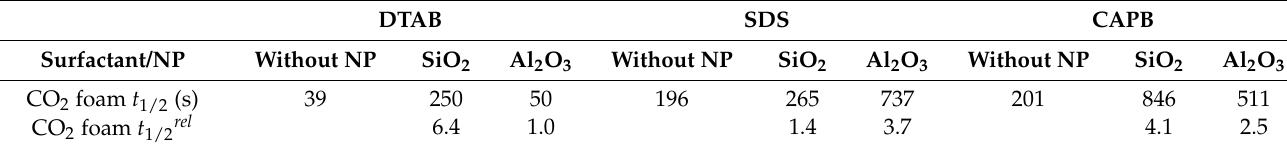
Table 4. Half-life ( t 1/2 ) and relative half-life ( t 1/2 rel ) of CO 2 foams containing surfactants and NPs (1.0 wt %) in desulphated seawater